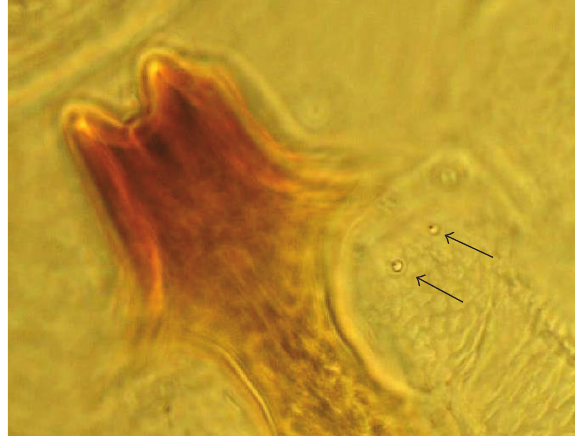
Figure 19: On the disc of each fleshy pad is a pair of haired papillae